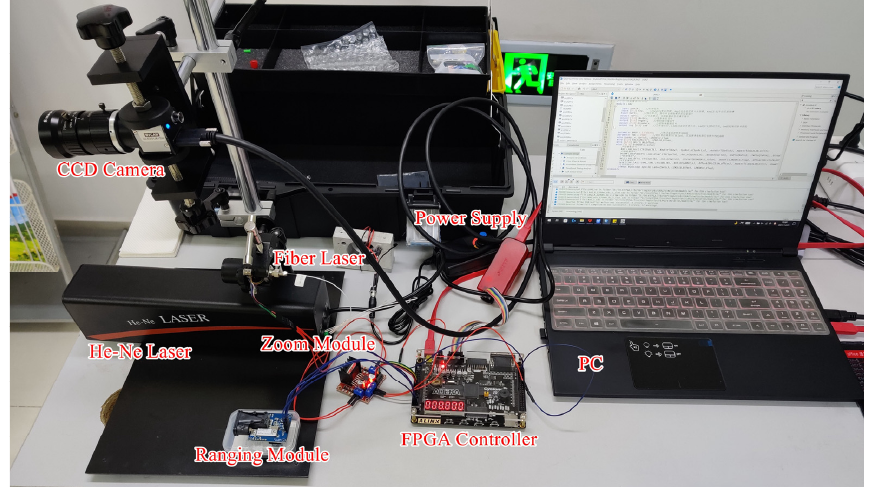
Figure 12. Equipment physical map.